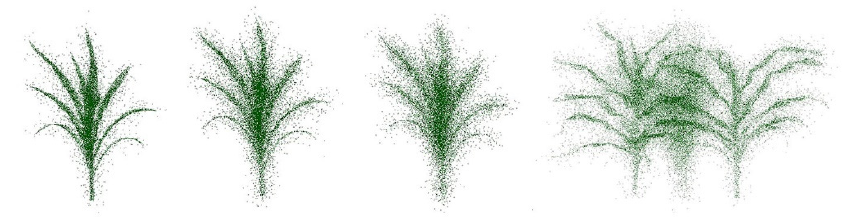
Figure 3. Overlapped images acquired for generating point clouds. Figure 4. Left to right: samples with 20%, 50%, and 70% outliers; three-plant grouping.